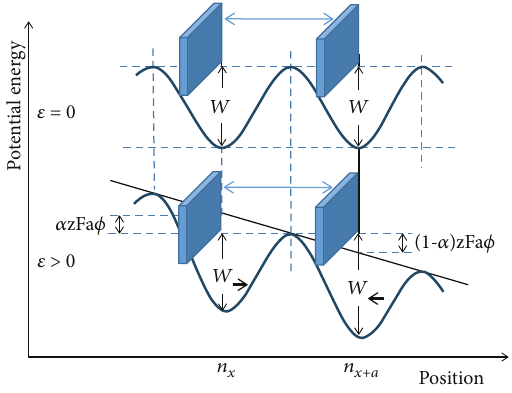
Figure 4: E ff ect of the electric potential on the activation barrier for the hopping mechanism between two adjacent planes in the oxide